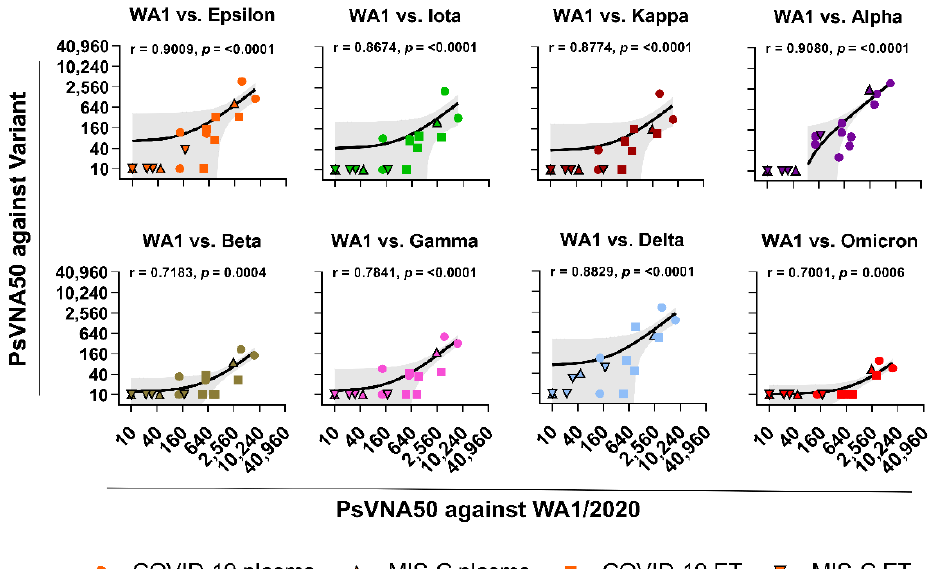
Figure 2. Relationship of neutralizing antibodies against SARS-CoV-2 WA1/2020 and variants. Correlation of SARS-CoV-2 WA1/2020 neutralizing titer versus VOIs; Epsilon, Iota, and Kappa, and VOCs; Alpha, Beta, Gamma, Delta, and Omicron variant neutralizing titer for plasma and endotracheal aspirates of pediatric patients with either COVID-19 ( n = 5) or MIS-C ( n = 5). Individual COVID-19 plasma samples are shown as circles, while MIS-C plasma samples are shown as triangles. The endotracheal aspirates samples from pediatric COVID-19 are shown as squares, while MIS-C are shown as inverted triangles. The black line in the scatter plots depicts the linear fit of log2 transformed PsVNA50 values with shaded area showing the 95% confidence interval. Associated correlations show spearman rank correlation coefficients (r) and two-tailed p values.